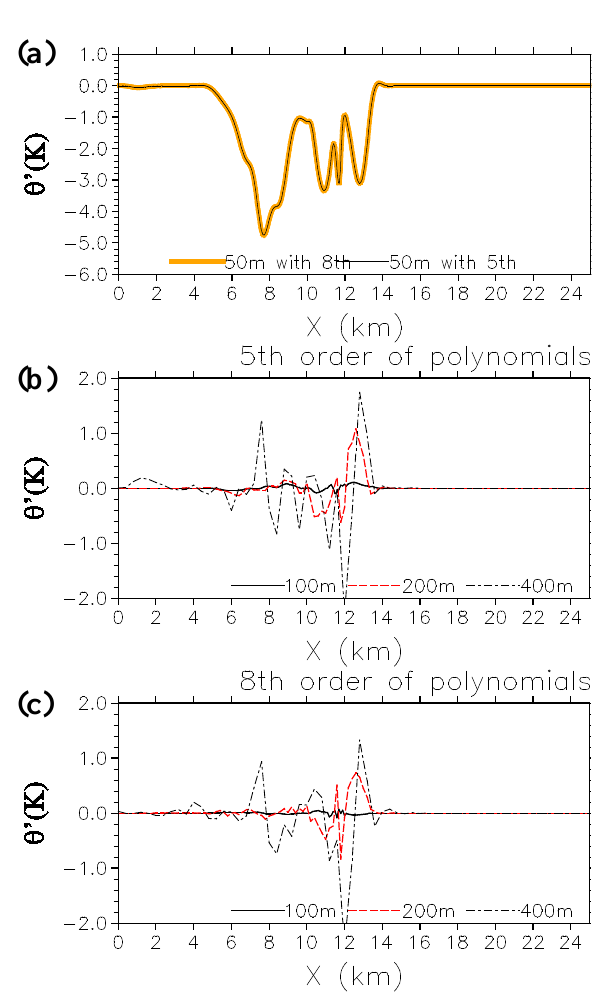
FIG. 7. Profiles of (a) potential temperature perturbation after 900 s along 1200 m height 2 Figure 7. Profiles of (a) potential temperature perturbation after 900s along 1200m height using grid spacing of (cid:49) ¯ x = 50m with using grid spacing of 50x ∆ = m with 5th-order (thin solid line) and 8th-order (thick solid 3 fifth-order (thin solid line) and eighth-order (thick solid line) basis line) basis function, (b) difference between various resolution and 50x ∆ = m with 5th-order 4 function, (b) difference between various resolution and (cid:49) ¯ x = 50m basis function, (c) difference between various resolution and 50x ∆ = m with 8th-order basis 5 with fifth-order basis function, and (c) difference between various resolution and (cid:49) ¯ x = 50m with eighth-order basis function. function. 6